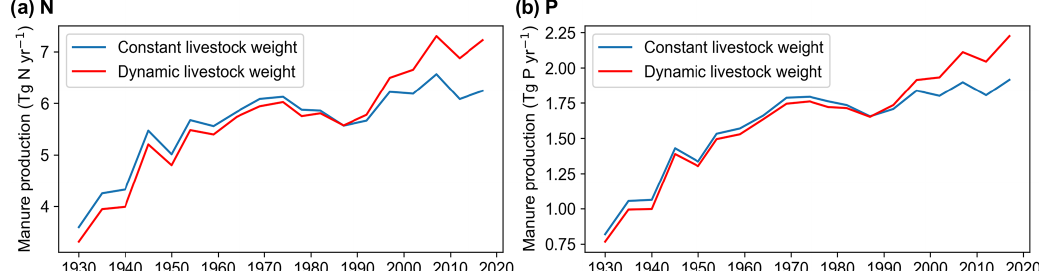
Figure 10. Comparison of manure N and P production calculated based on dynamic weight of livestock and constant